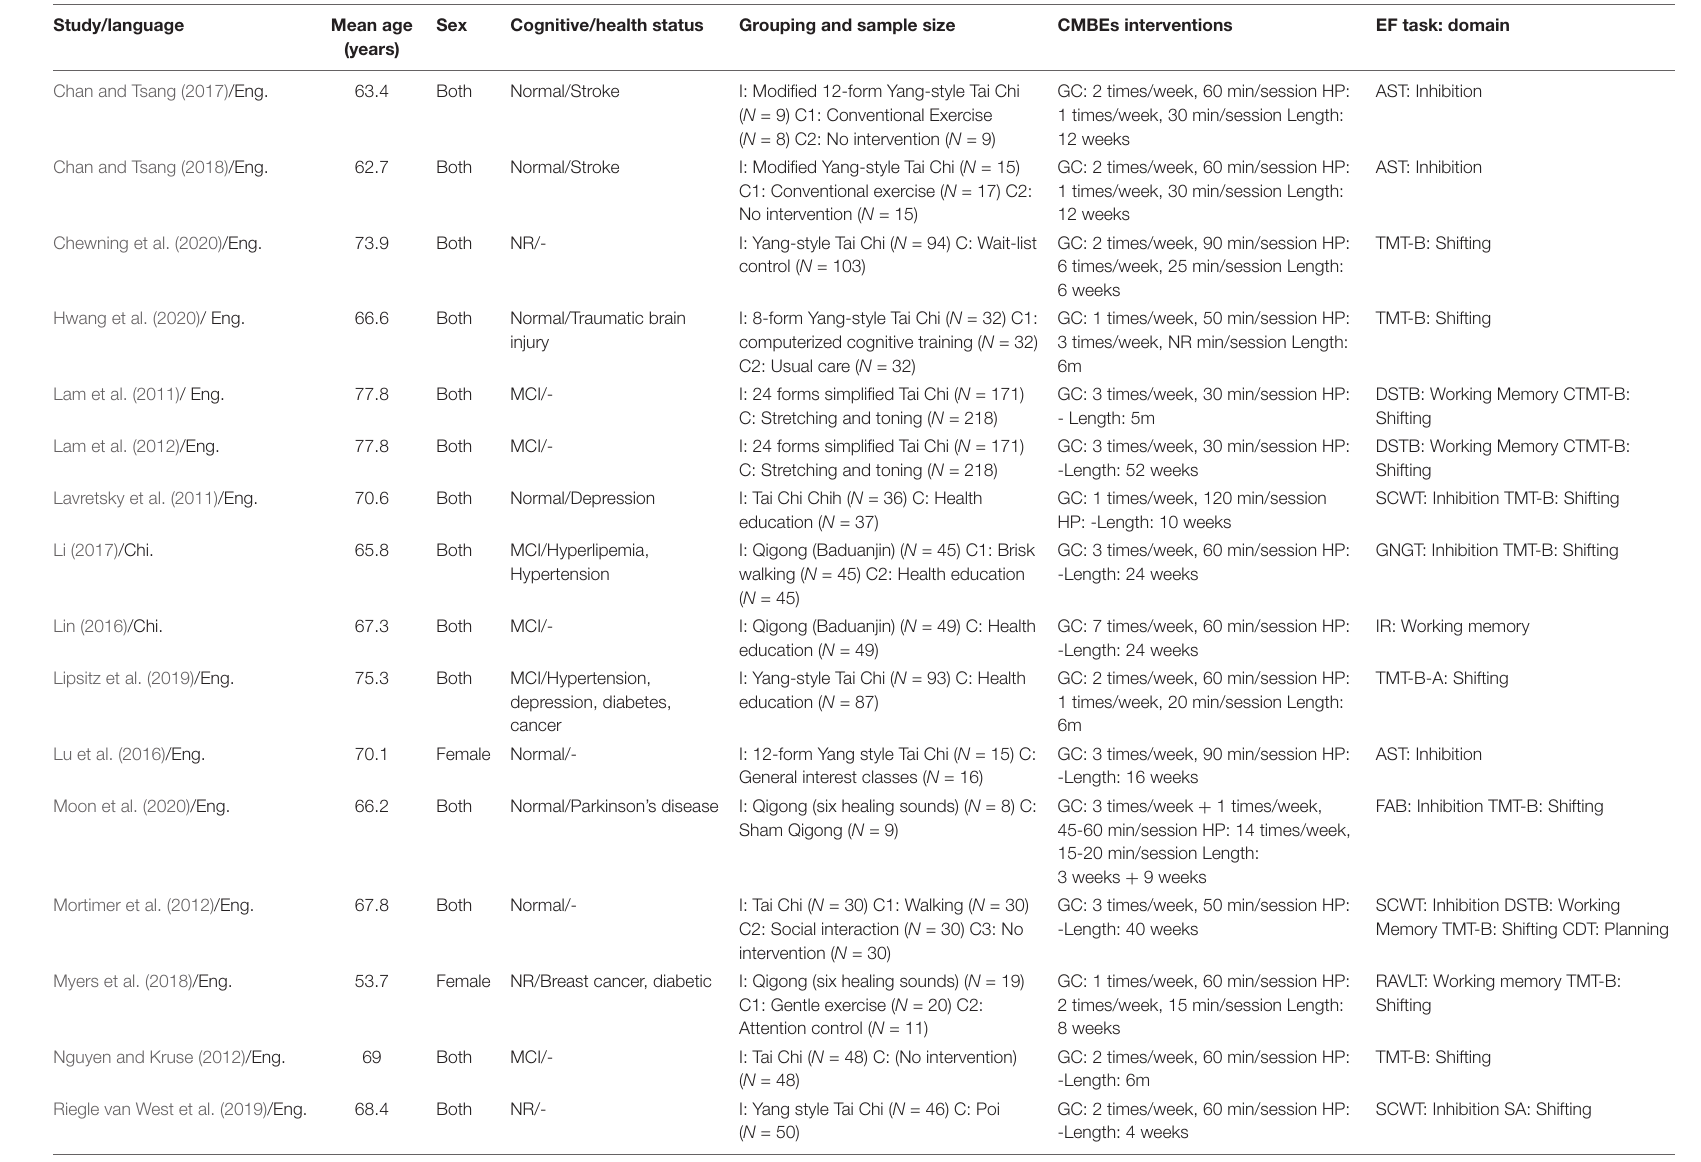
TABLE 2 | Overview of characteristics associated with Chinese mind-body exercises and executive function studies ( n = 29).